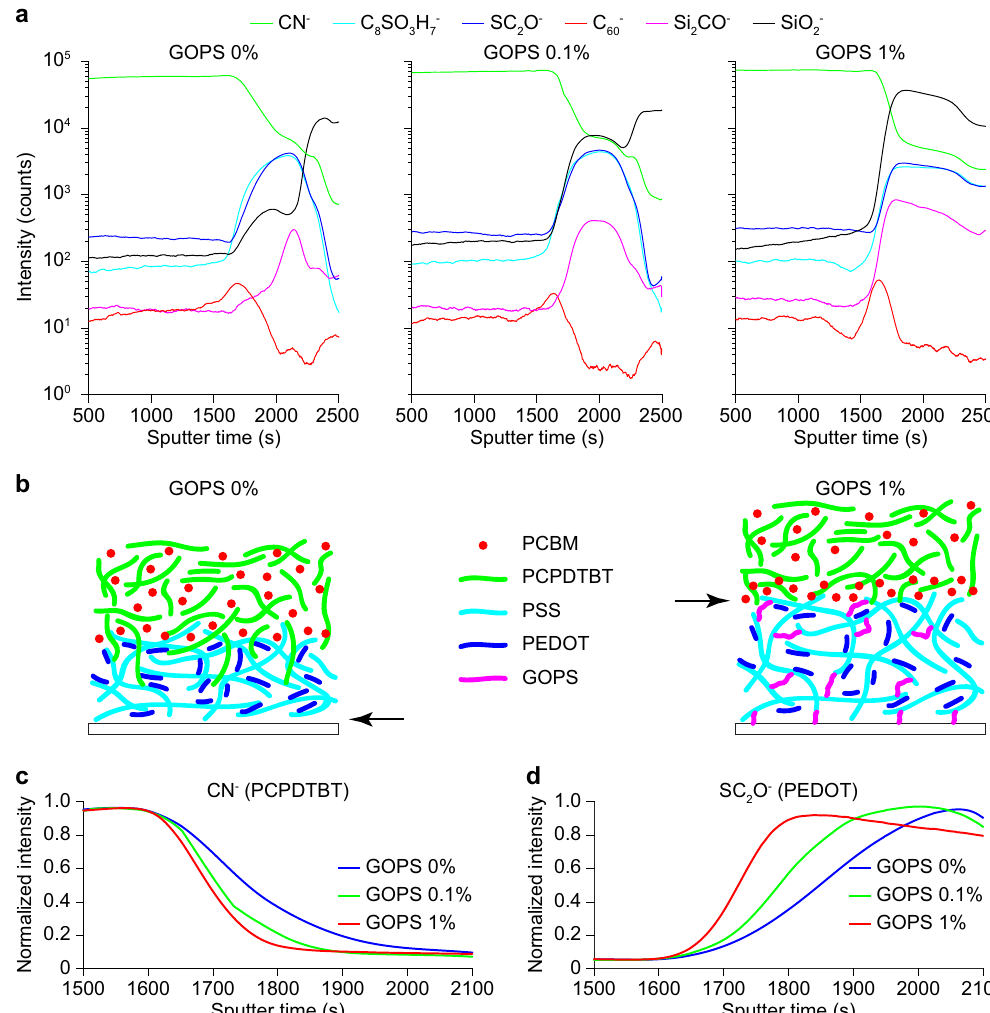
Fig. 7 Redistribution of molecules as a function of the GOPS concentration. a Smoothed ToF-SIMS depth pro fi les (negative polarity) conducted on the organic layers with 0, 0.1, and 1 v/v% of GOPS. CN − , C 8 SO 3 H 7 − , SC 2 O − , C 60 − , Si 2 CO − , and SiO 2 − are used as proxies respectively for PCPDTBT, PSS, PEDOT, PC 60 BM, GOPS, and both glass and GOPS. The interface between PCPDTBT:PC 60 BM and PEDOT:PSS is roughly at 1700 s, while the one between PEDOT:PSS and the glass substrate is roughly at 2100, 2250 and 2400 s for pristine PEDOT:PSS, with 0.1 v/v% GOPS, and with 1 v/v% GOPS, respectively. b Schematic representation of the deduced organization of the organic molecules for 0 v/v% (left) and 1 v/v% (right) of GOPS. The arrows indicate the observed delamination level within the organic layers. c , d Normalized intensities of the depth pro fi les for PCPDTBT (CN − ) ( c ) and PEDOT (SC 2 O − ) ( d ) for the three GOPS